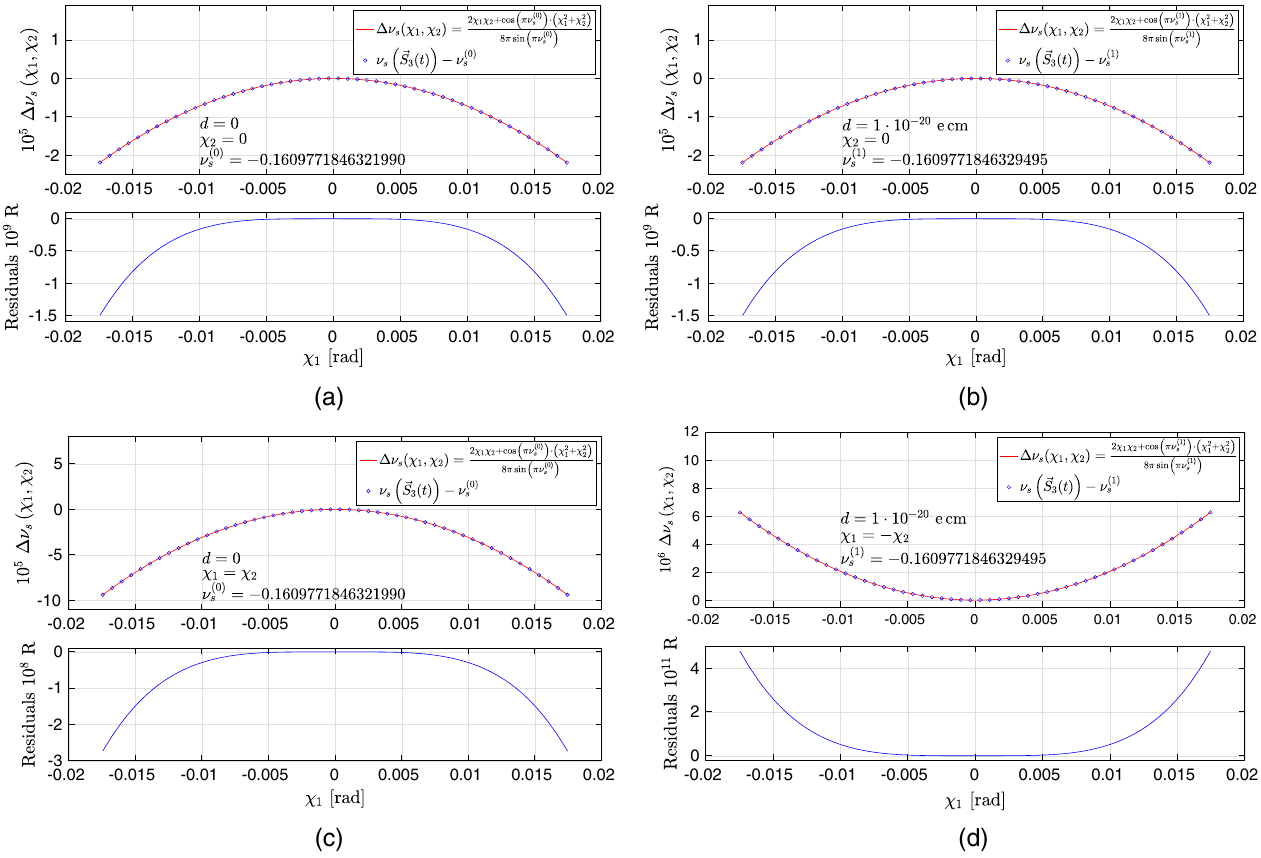
ð χ χ Þ for deuterons using two solenoids in the machine (as indicated in Fig. 15) under the 1 ; 2 s ⃗ S 3 ð t Þ from Eq. (100). Panels (a) and (c) show for d ¼ 0 Δ ν ð χ χ Þ ¼ ν ð t Þ − ν ð 1 Þ 1 ; 2 s . Panels (a) and (b) s s